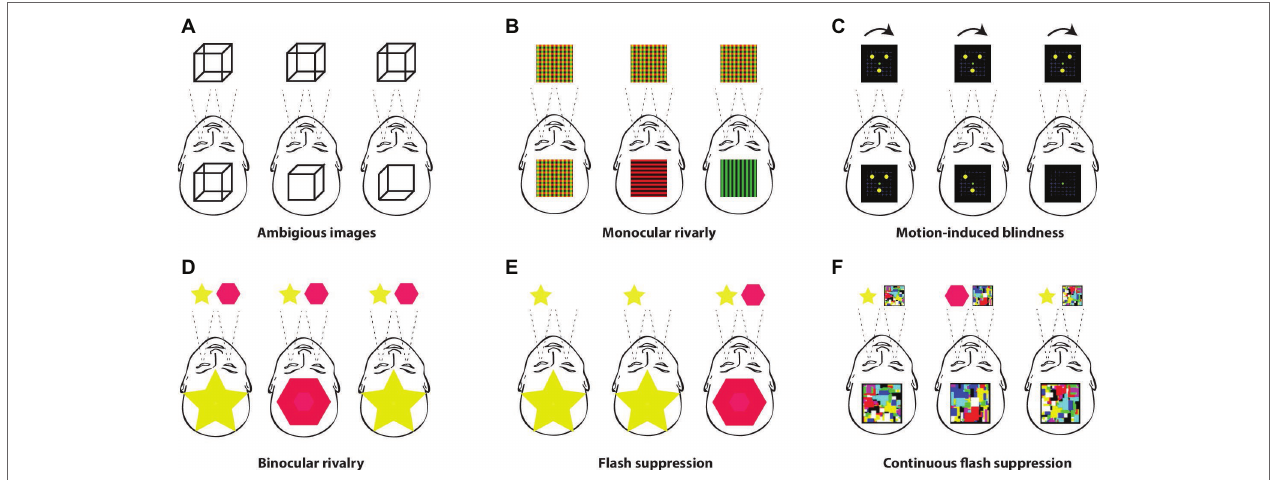
FIGURE 1 | Multistable paradigms. (A) The first in the family of multistable paradigms are ambiguous images such as Necker cube, Rubin’s vase, and Schröder’s stairs. Prolonged viewing of such stable and unchanging images will eventually result in two different conscious perceptions, which spontaneously fluctuate between each other (e.g., Kleinschmidt et al., 1998; Schmack et al., 2015). (B) Monocular rivalry is a similar phenomenon. It occurs during prolonged viewing of two superimposed visual images, e.g., green and red lines. After some time, one image becomes clearer and eventually exclusively dominant, while the other fades from the conscious experience (O’Shea et al., 2009). (C) A similar form of fading away from consciousness can be achieved by the motion-induced blindness paradigm, in which several stable points, such as yellow circles, fade away from consciousness and are rendered unconscious when presented against moving dots (Bonneh et al., 2001). (D) Probably the best-known paradigm of conscious studies is binocular rivalry. In this visual paradigm, two different visual patterns (e.g., a star and a diamond, a face and a house, etc.) are presented to each eye separately. Conscious experience spontaneously fluctuates between the two images despite the constant and unchanging visual input to each eye (Klink et al., 2013). (E) The paradigm of flash suppression (Wilke et al., 2003) was developed as a methodological solution to the spontaneous and unpredictable switches of conscious perception under the binocular rivalry paradigm. A stimulus presented to one retina is rendered completely invisible by the sudden presentation (“flash”) of a different image to the other retina. (F) The continuous flash suppression paradigm utilizes constantly moving colored squares called “mondrians” (Tsuchiya and Koch, 2005). Such a salient and ever-changing stimulus presented to one eye completely prevents rivalrous stimuli presented to the other eye from entering the stream of consciousness, thus rendering them entirely invisible for long periods of